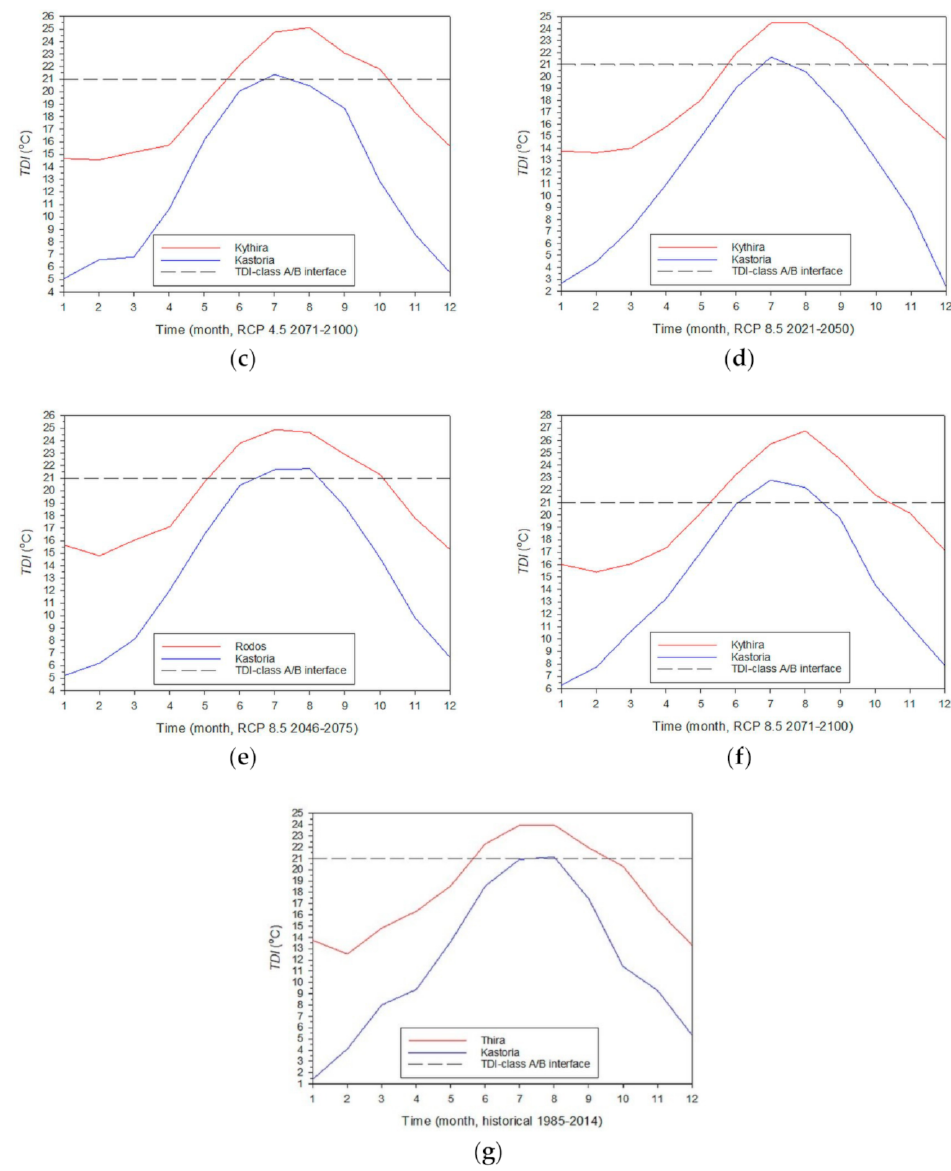
Figure 7. Intra-annual variation of TDI in the epochs: ( a ) RCP 4.5 2021–2050, ( b ) RCP 4.5 2046–2075, ( c ) RCP 4.5 2071–2100, ( d ) RCP 8.5 2021–2050, ( e ) RCP 8.5 2046–2075, ( f ) RCP 8.5 2071–2100, and ( g ) historical 1985–2014 at selected sites in Greece. The dashed lines are the interfaces between the class A (TDI < 21 ◦ C) and class B (TDI ≥ 21 ◦